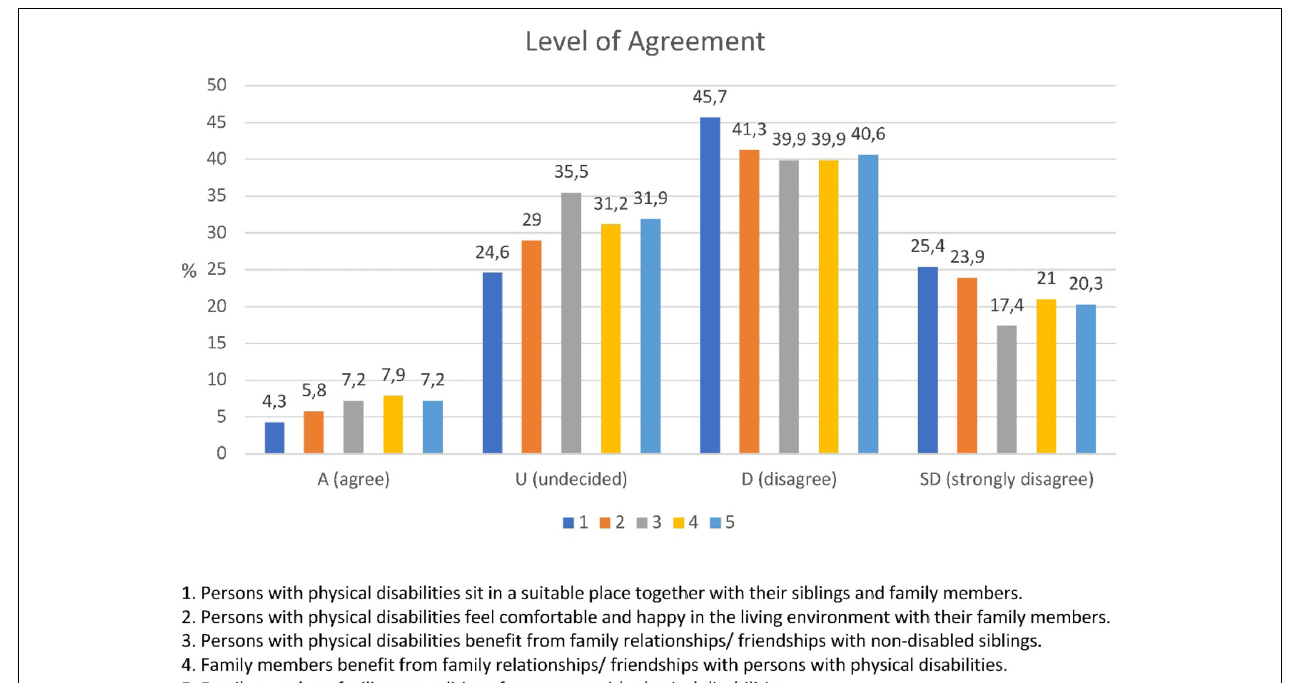
FIGURE 6 | Interaction between parent and person with